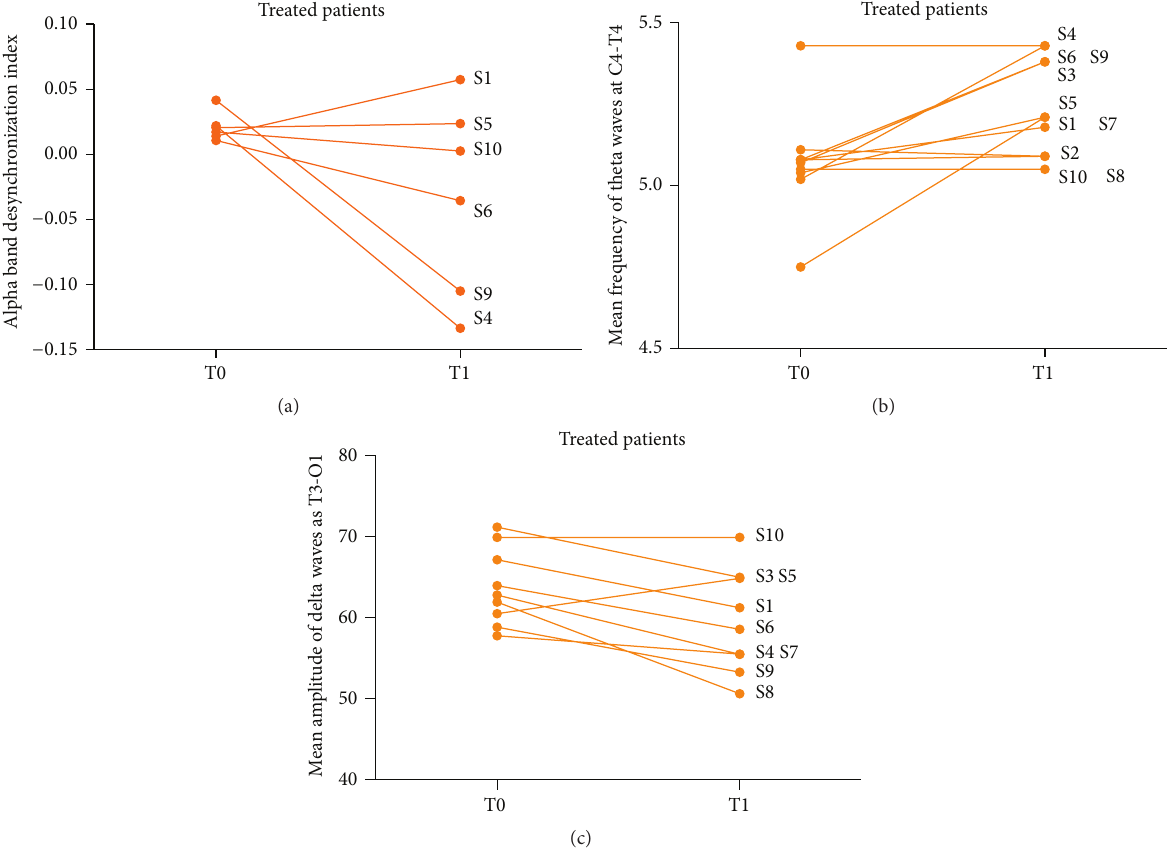
Figure 4: EEG parameters assessed before (T0) and after (T1) IGF-1 treatment. Alpha band desynchronisation is shown for those patients who were more anxious at baseline 𝐿 > 𝑅 (a). The mean frequency of theta waves at C4-T4 (b) is also shown as is the mean amplitude of delta waves at T3-O1 (c). S1–10: treated subjects